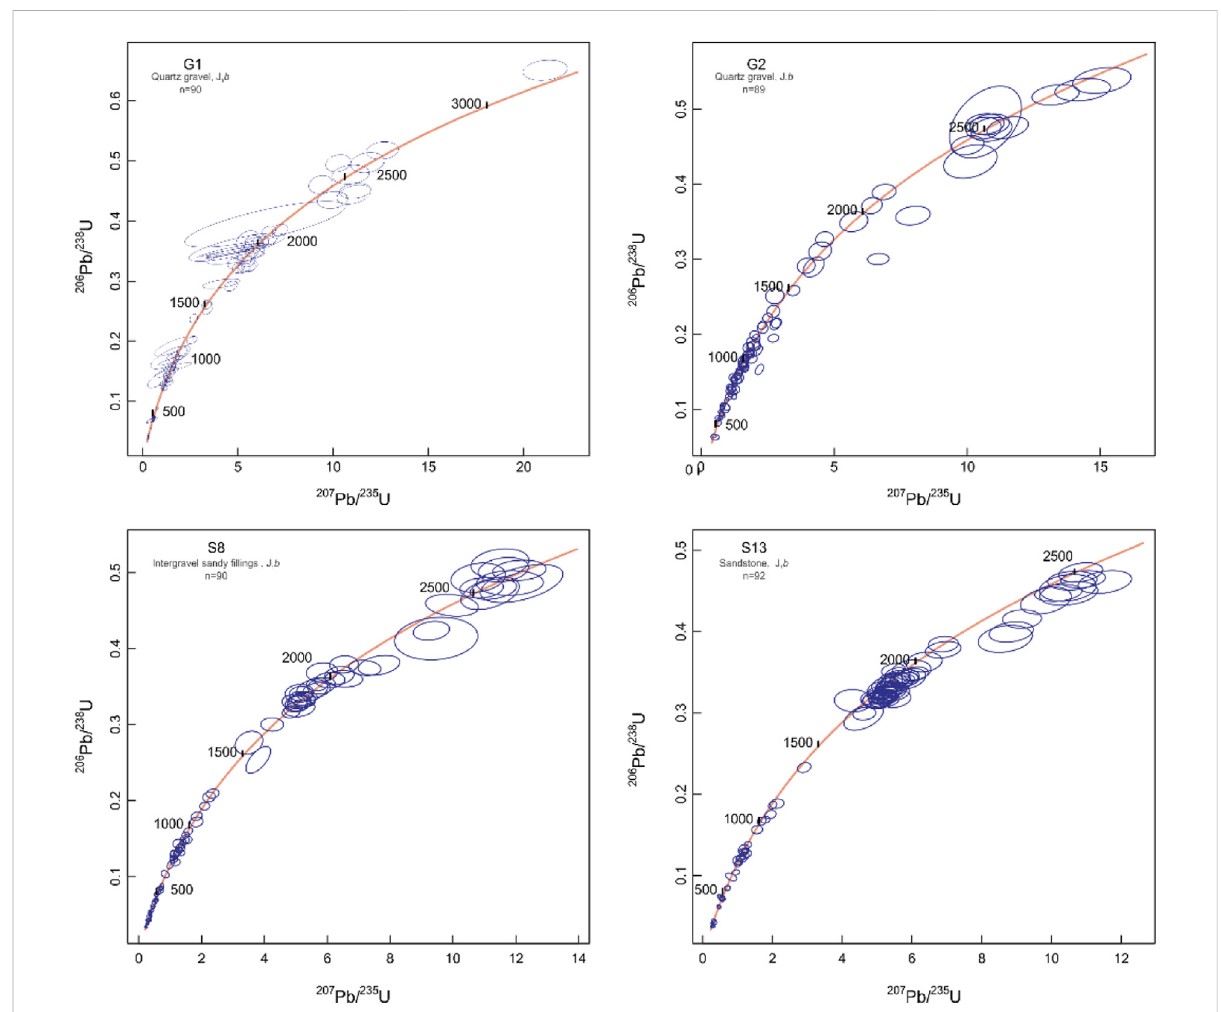
FIGURE 5 U-Pb concordia diagrams for zircon grains of each